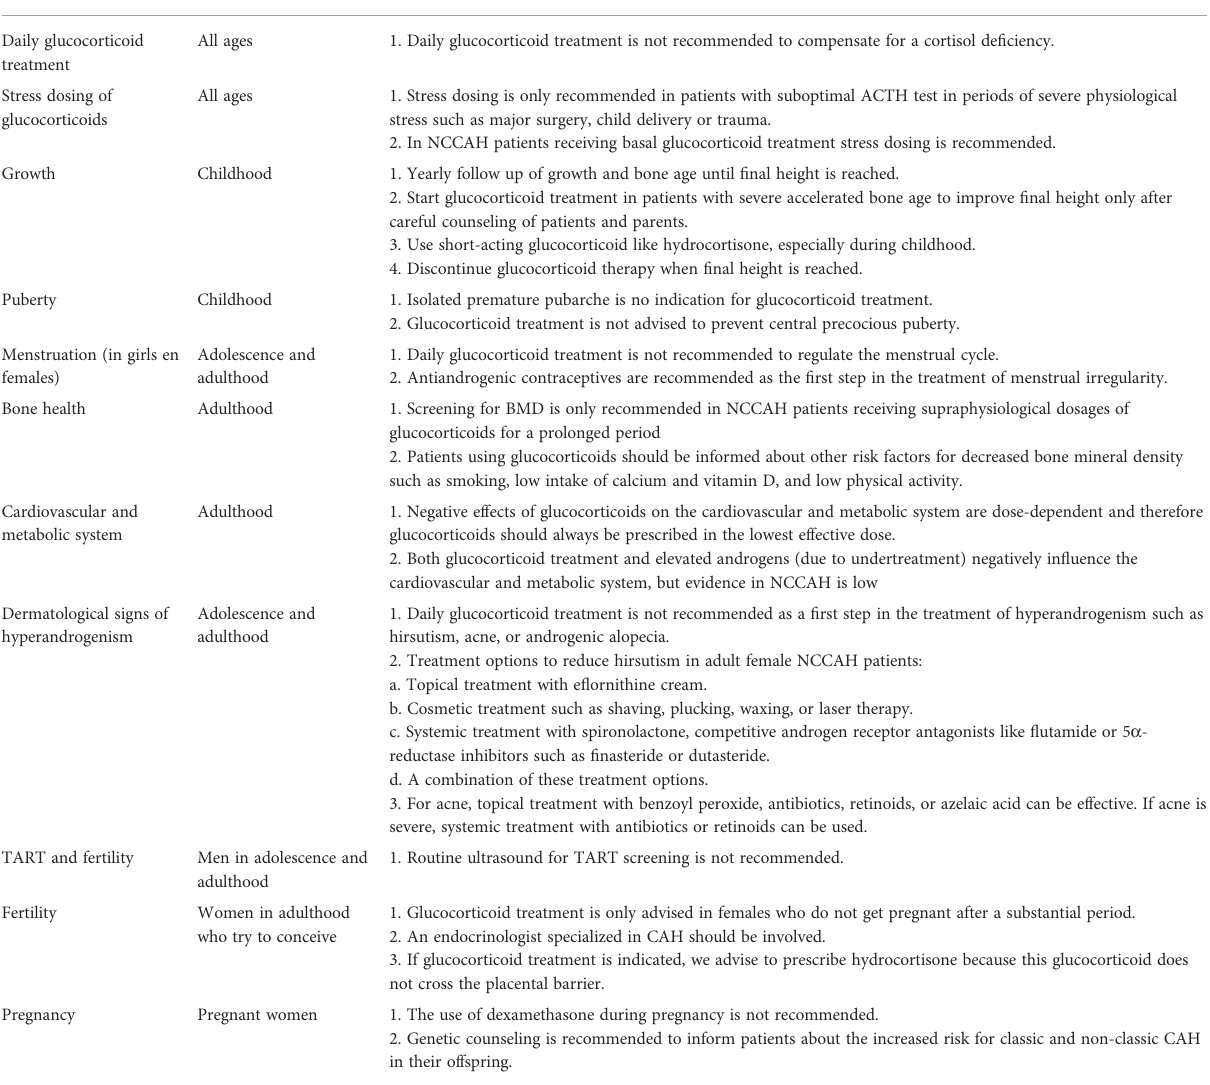
TABLE 1 Recommendations for monitoring and treatment of NCCAH